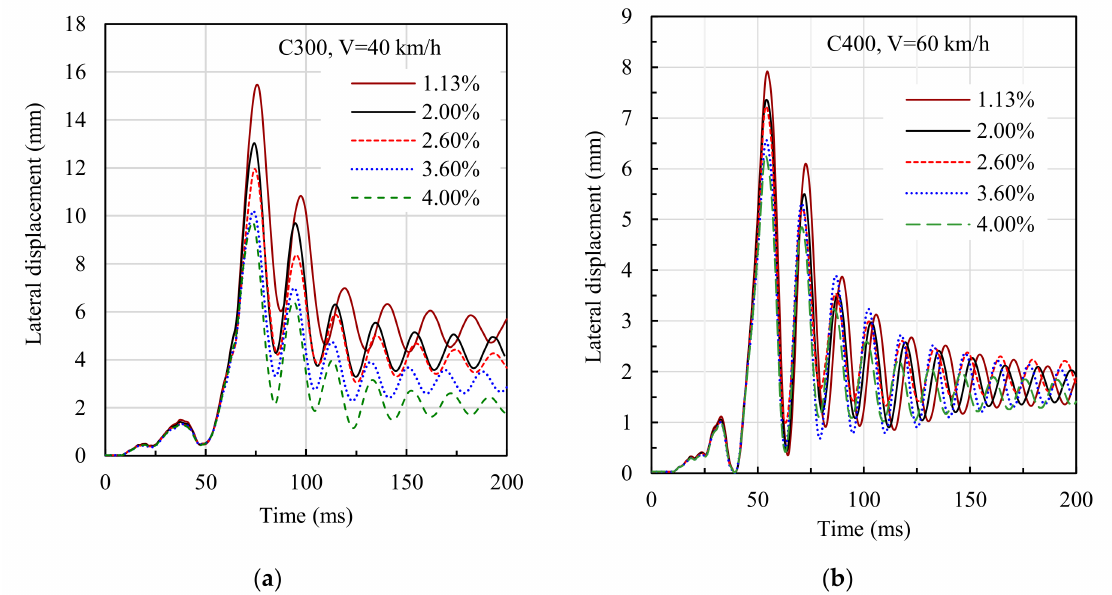
Figure 16. Effect of reinforcement ratio on the lateral displacement at 1740 m height: ( a ) column size 300 × 300 mm and impact velocity of 40 km/h; ( b ) column size 400 × 400 mm and impact velocity of 60